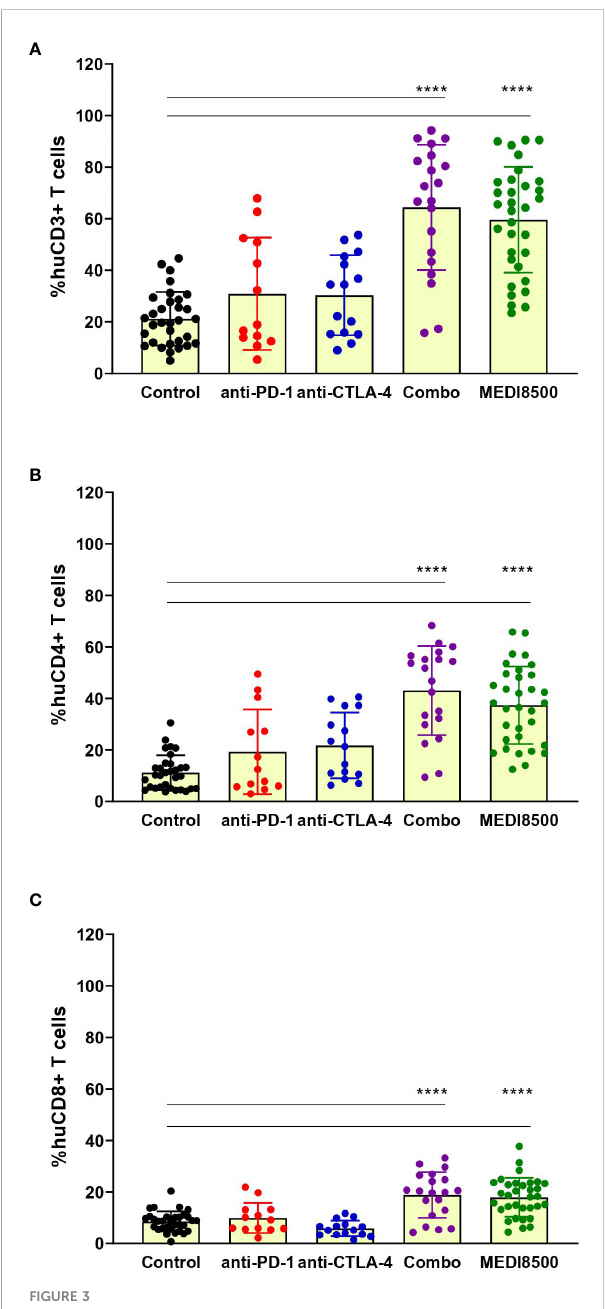
FIGURE 3 Signi fi cant expansion of T cells with antibody combination and MEDI8500 compared to monotherapies. Flow cytometry analysis of the percentages of (A) huCD3 + T cells, (B) huCD4 + T cells and (C) huCD8 + T cells in spleen of mice at sacri fi ce. Data are represented as percentage within huCD45 + population for each individual mouse and as Mean ± SD of all mice in each treatment group. Mice numbers are the same as in Figure 2A. A one-way ANOVA followed by Tukey ’ s multiple comparison was used to evaluate statistical differences between treatment and control groups; **** P <